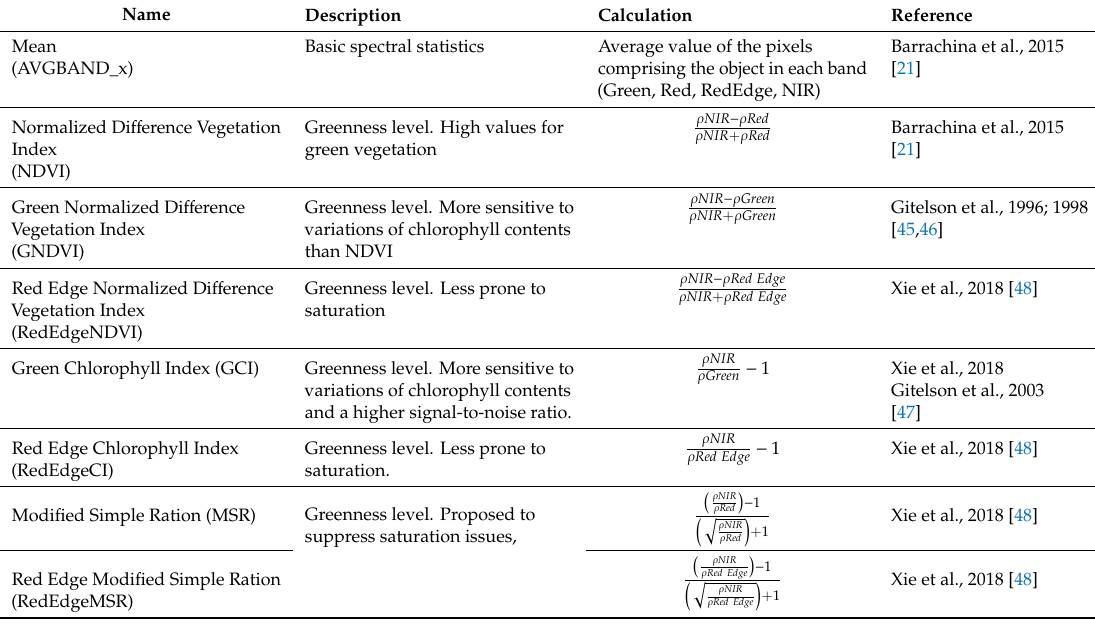
Table 1. Characterization of the spectral indices used in this study. Acronyms in